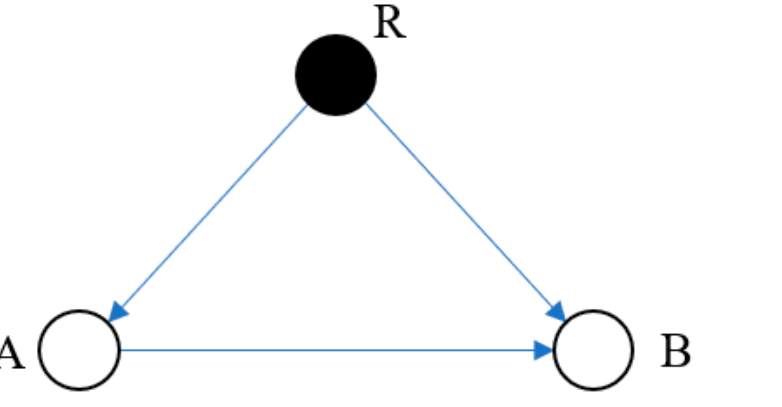
Figure 10. RBS protocol message exchange.